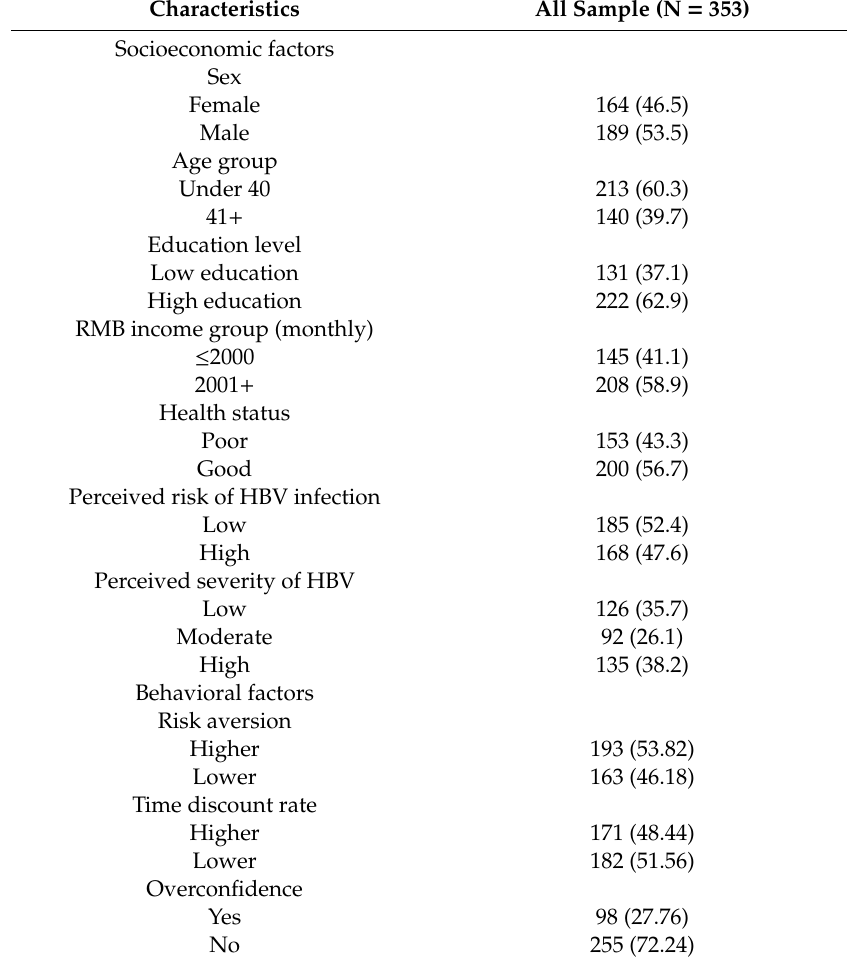
Table 2. Respondent